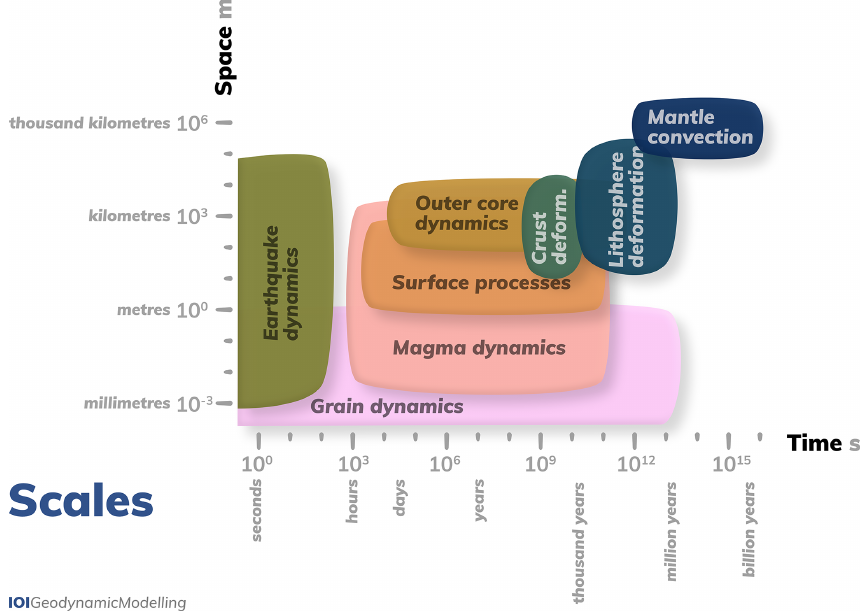
Figure 1. Spatial and temporal scales of common geodynamic processes. These processes occur over a wide range of timescales and length scales, and modellers have to take into account which of them can be included in any given